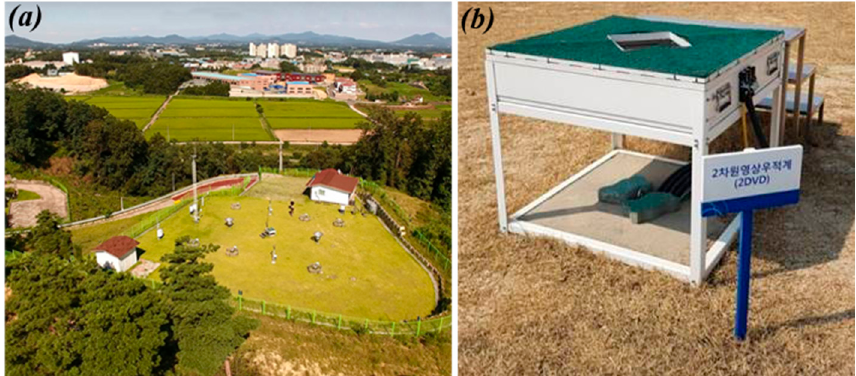
Figure 2. ( a ) Observation field managed by KMA and ( b ) the 2DVD deployed in the field. Table 2. Specifications of YIT.